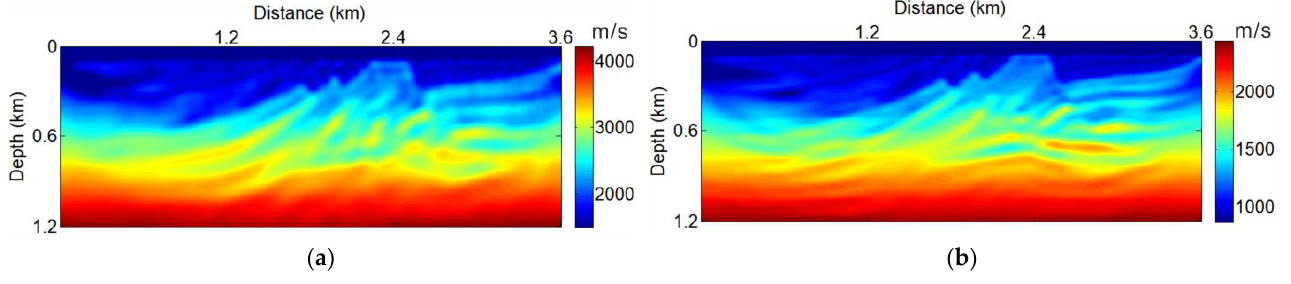
Figure 9. Low-frequency data (5 – 10 Hz) based PC-EFWI results with phase correction factor ε = 0.3 using Figure 8 for initial velocity models; ( a ) V p ; ( b ) V s .